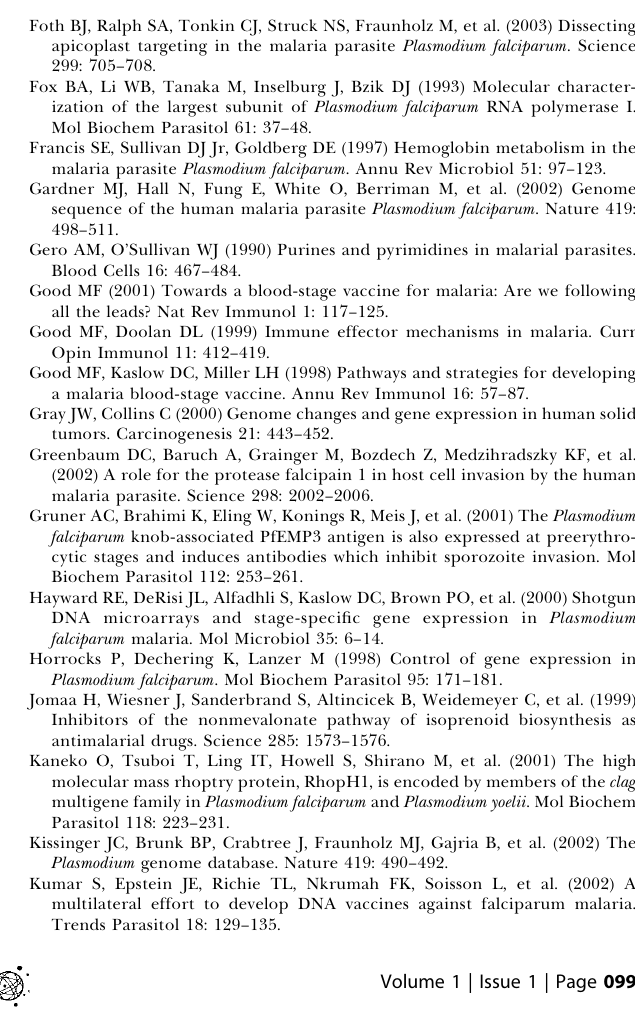
Table S7. Vaccine Candidate Correlation